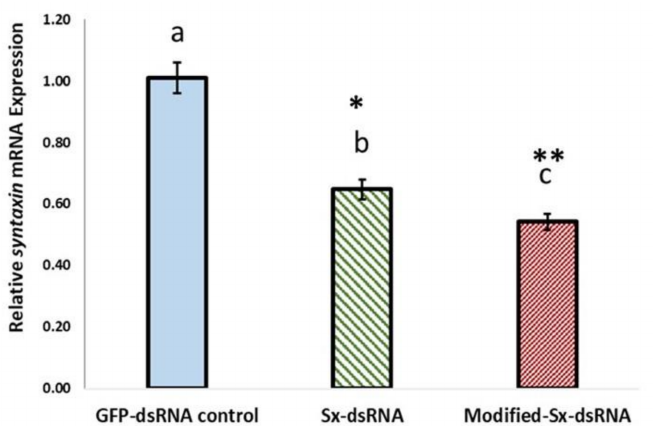
Figure 10. Mean fold-change in the expression of Syntaxin-1A mRNA in adult Bemisia tabaci. Whitefly were fed on okra seedlings treated with either modified- and unmodified- Syntaxin -dsRNA compared to unmodified GFP-dsRNA treated control. Whitefly Syntaxin-1A expression was significantly reduced when whitefly fed on plants treated with either Syntaxin -dsRNA, showing a change of 1.6 ( ± SE 0.1) and 1.9 ( ± SE 0.08) fold down-regulation, respectively. The modified Syntaxin -dsRNA treatment was significantly different from the unmodified Syntaxin- dsRNA (** p < 0.01), and both were significantly different from the GFP-dsRNA control (* p < 0.05). The GFP-dsRNA Syntaxin mRNA expression level set to 1.00. Error Bars represent the ± SE of means, (n = 9), from three biological replicates and three independent experiments. Bars with different letters are significantly different.